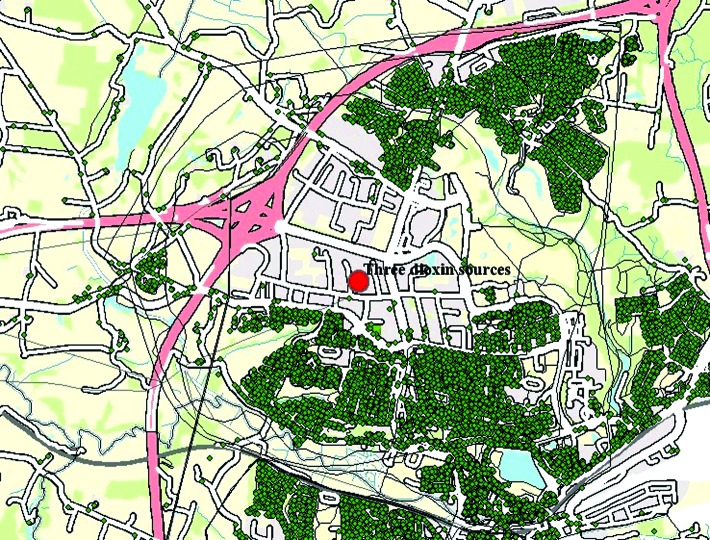
Map of Kolding Town with dioxin source in red and address points in green .